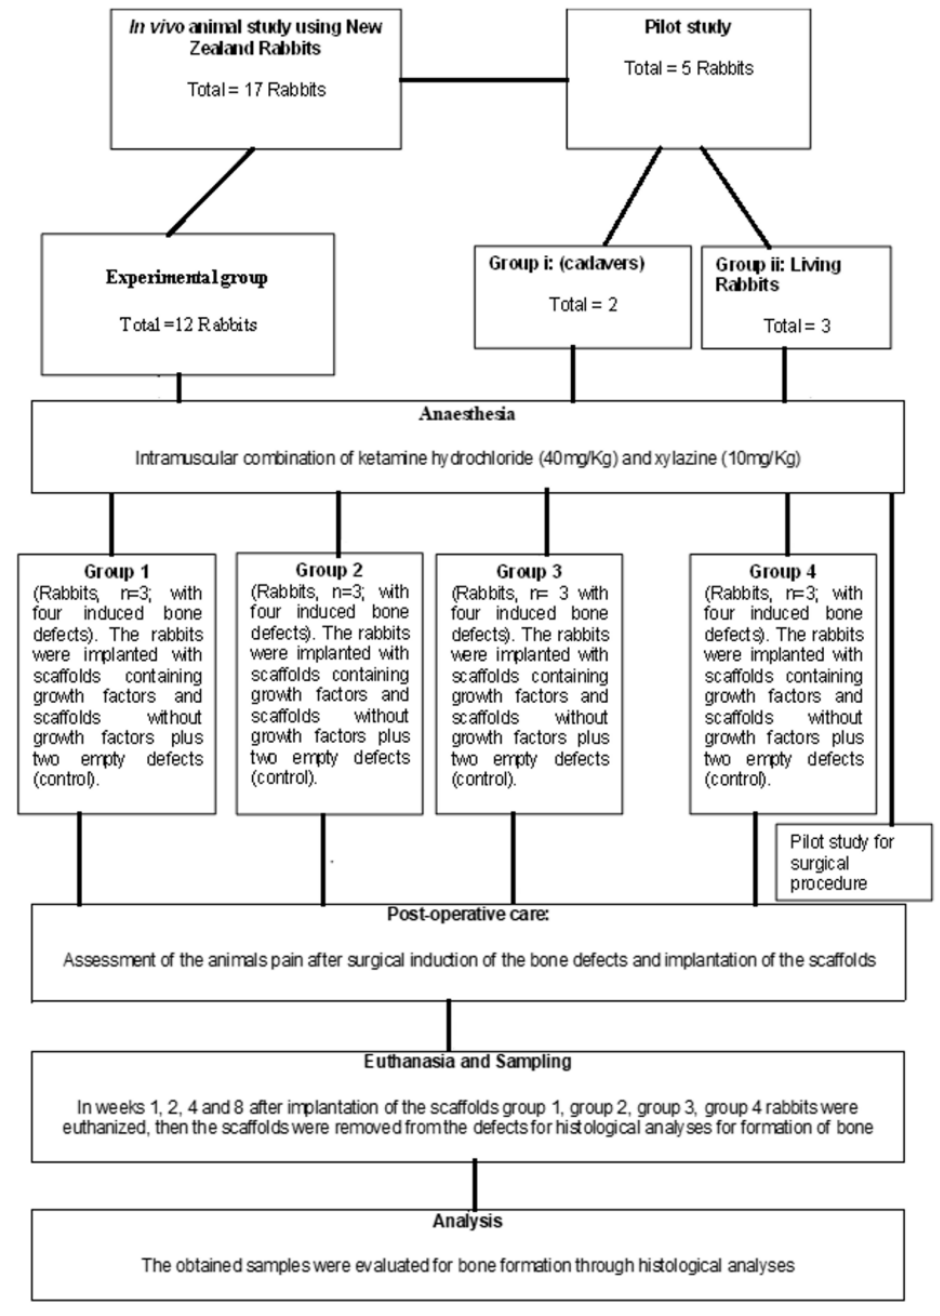
Figure 9. Schematic showing the in vivo studies model for the implanted scaffold.